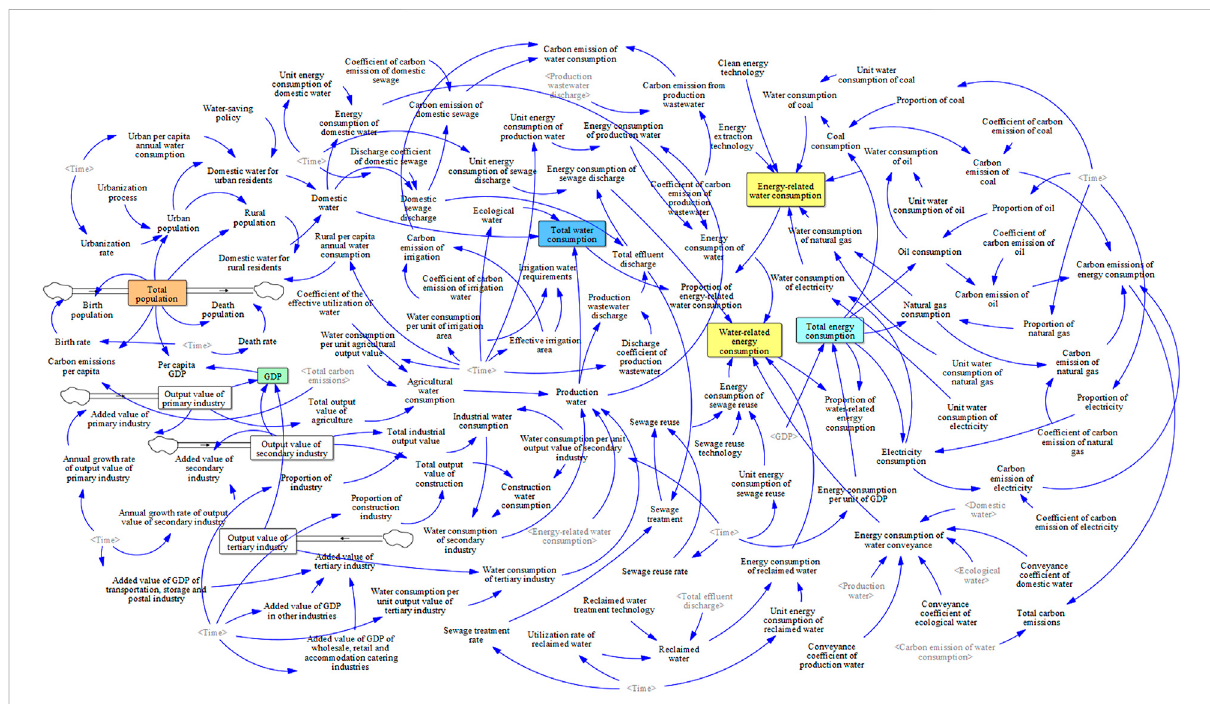
FIGURE 3 System dynamics model of carbon emission in Taiyuan under energy-water coupling